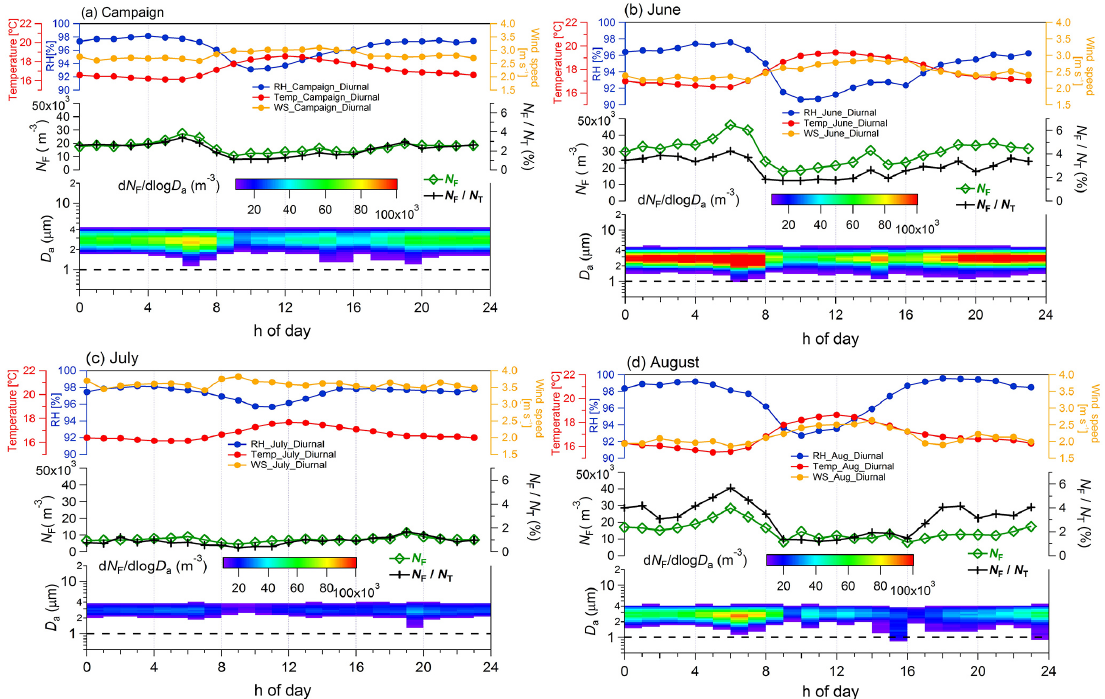
Figure 4. Diurnal cycles of observed meteorological parameters, FBAP number concentrations ( N F ) and size distributions averaged over individual months of measurement and the entire campaign (hourly mean values plotted against the local time of day). The upper portion of each panel shows the observed meteorological parameters: relative humidity (%; blue), temperature ( ◦ C; red), and wind speed (ms − 1 ; orange on the right axis). The middle panel shows the integrated FBAP number concentration ( ∼ 1–20µm; N F ) on the left axis (green) and the FBAP fraction of the TAP number ( N F /N T ) on the right axis (black). The lower portion of each panel FBAP number size distribution (3-D plot) plotted against the hour of the day on the x axis and the aerodynamic diameter on the y axis and color scaled for d N F / dlog D a indicate the concentration. Dashed black lines in the lower portion of each panel at 1.0µm show the particle size cutoff diameter below which fluorescent particles were not considered to be FBAPs due to potential interference with non-biological aerosol particles. (a) averaged over the entire campaign, (b) June, (c) July, and (d) August. Please refer to the figures in the Supplement for corresponding TAP